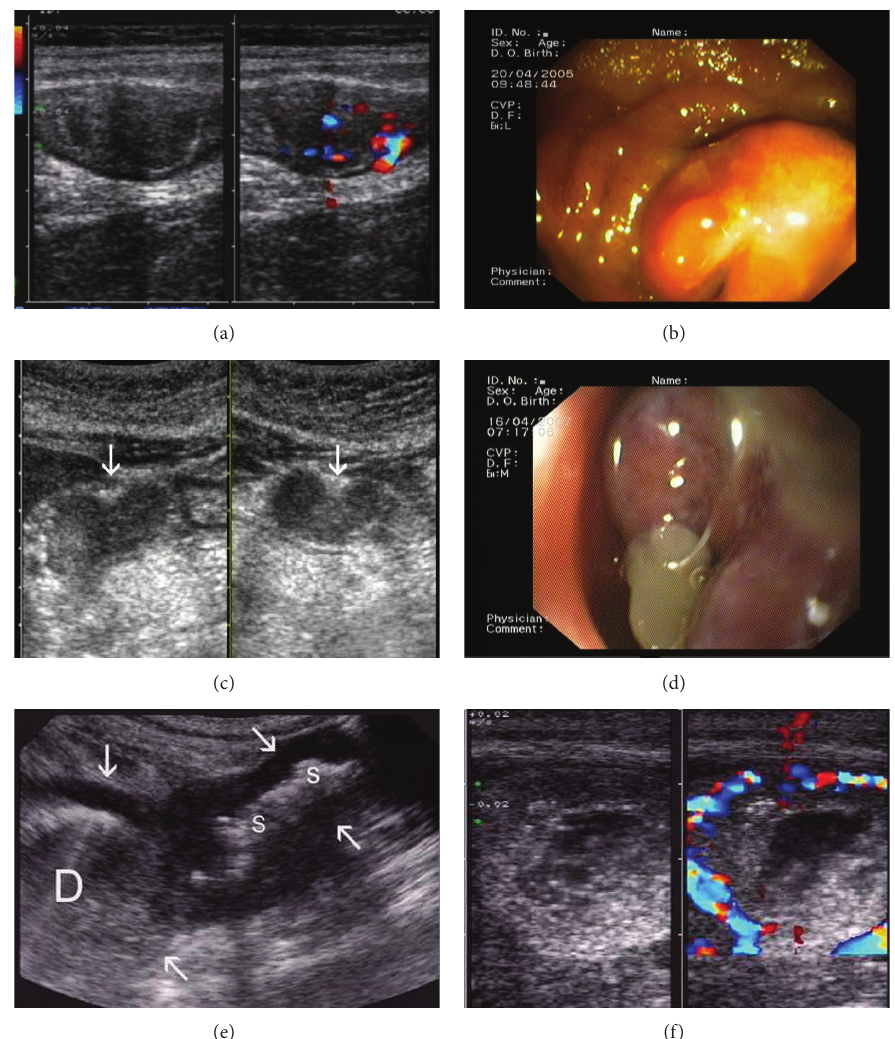
Figure 5: Tumors of small bowel. (a) Solid oval tumor in the lumen of terminal ileum with hypervascularisation in CFD (a) High resolution probe . (b) Endoscopic picture of tumor of terminal ileum in the same case-histologically carcinoid. (c) Oval solid tumor in D2 segment of duodenum— Standard abdominal probe . (d) Endoscopic view in the same case—histologically metastasis of Grawitz tumor (years after nephrectomy for tumor). (e) Longitudinal section of thickened small bowel loop (S) with stenosis and dilatation (D) of lumen. Standard abdominal probe . (f)Transversal view with high resolution probe in dilated segment shows hypervascularisation of thickened wall (f). Surgery confirmed suspected T-lymphoma of jejunum in untreated celiac